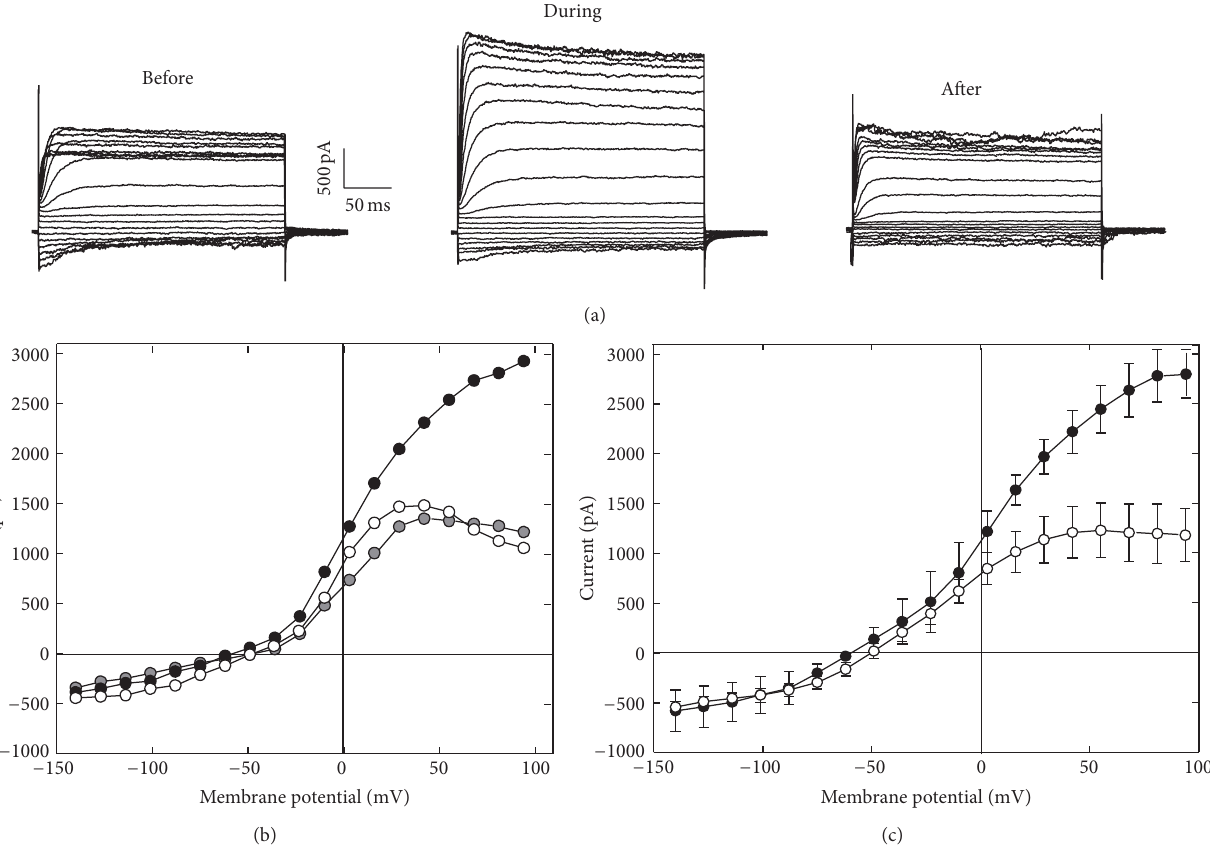
Figure 3: Urethane-induced membrane current changes. (a) Example of the membrane current waveforms recorded from a solitary OHC before, during, and after 100 mM urethane application. The cell was held at − 70mV, and voltage commands varied from − 140 to +94mV in 13mV steps. (b) The 𝐼 - 𝑉 curves derived from the steady-state responses shown in (a). The open, black, and gray filled circles represent the responses before, during, and after urethane application, respectively. (c) Plot of the average ( ± SD) 𝐼 - 𝑉 curves recorded from OHCs ( 𝑛 = 11 ) before (open circles) and during (filled circles) urethane